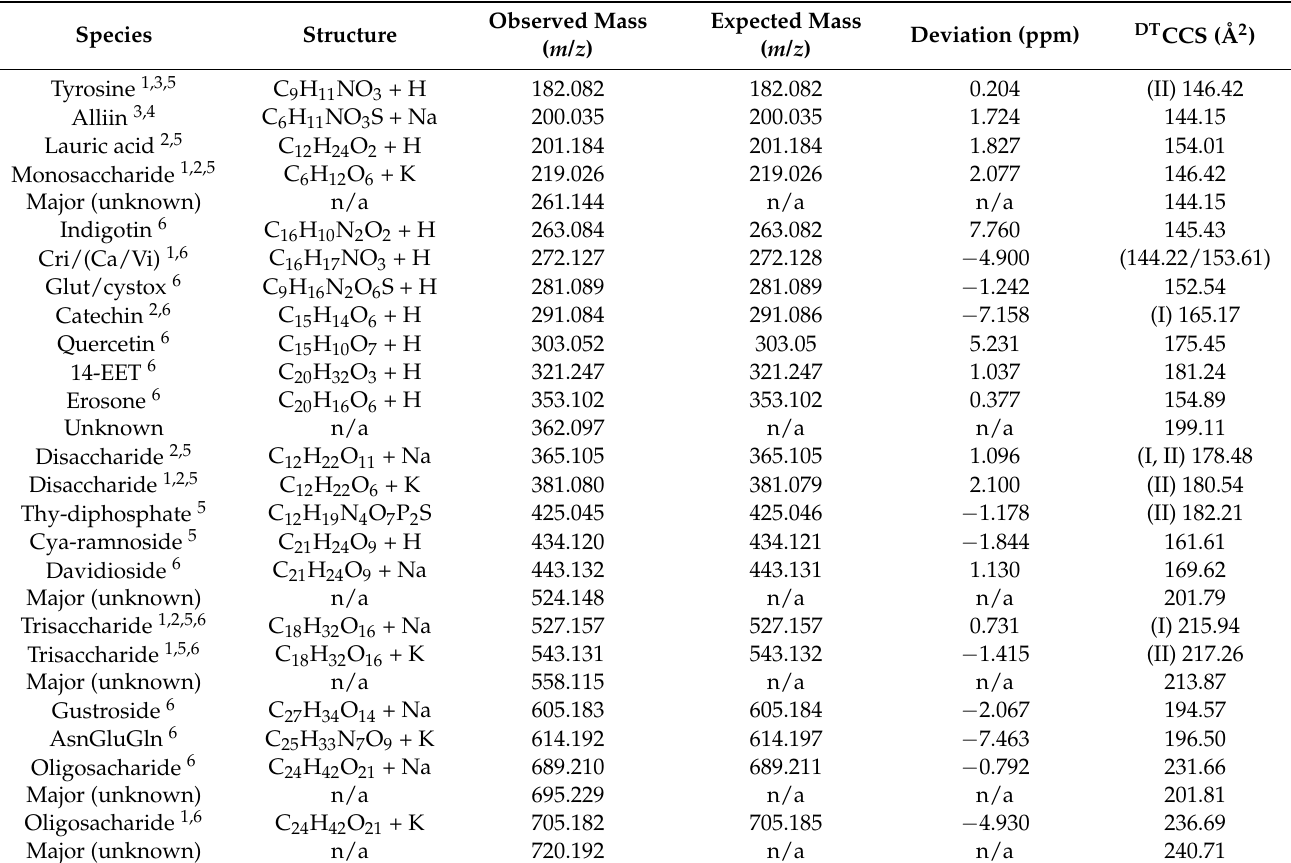
Table 1. Putative molecular assignments from LAESI-DTIMS analysis of single A. Cepa epidermal cells.